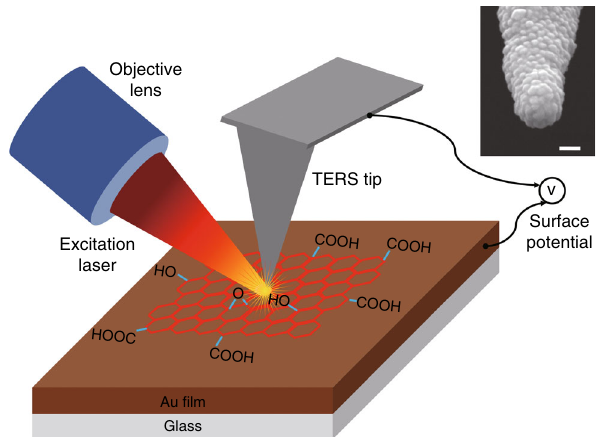
Fig. 1 Schematic diagram of the experimental setup. The side illumination AFM-TERS setup used in this work. Au coated AFM probe in combination with 638 nm excitation laser is used for in situ topographical, chemical and electrical nanoscopy of a GO – COOH sample. Scanning electron microscopy (SEM) image of a representative Au coated TERS probe is shown inset. Scale bar: 100